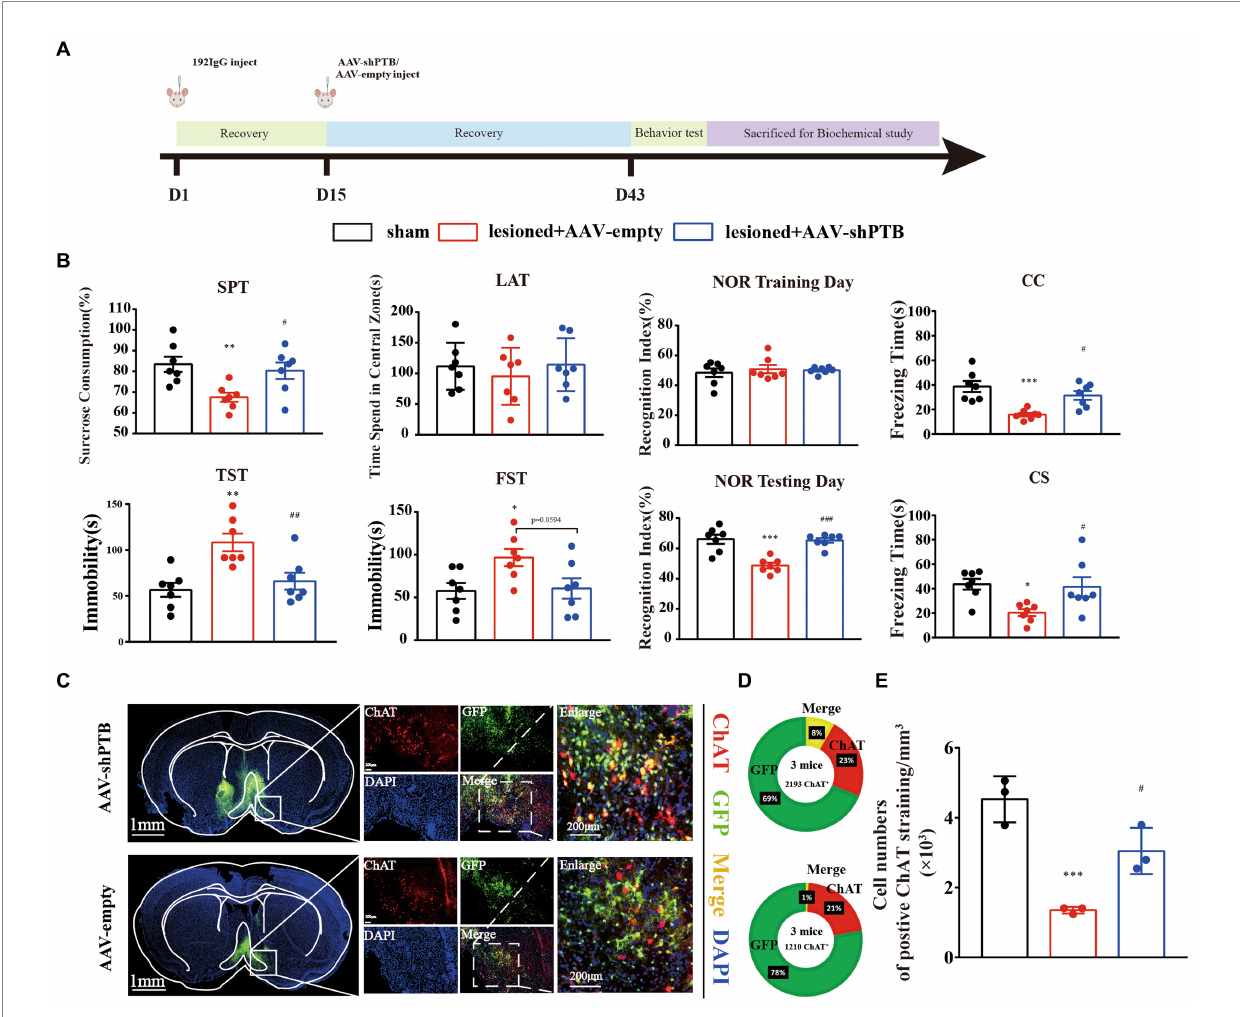
FIGURE 2 AAV-shRNA with GFAP promoters could replenish cholinergic neurons. (A) Experimental schedules. (B) The sucrose preference (one-way ANOVA, Tukey’s multiple comparisons test, F (2,18) = 6.235, ** p = 0.0099, # p = 0.0389, n = 7); immobility time in the TST (one-way ANOVA, Tukey’s multiple comparisons test, F (2,18) = 9.712, ** p = 0.0017, ## p = 0.0089, n = 7) and FST (one-way ANOVA, Tukey’s multiple comparisons test, F (2,18) = 4.407, * p = 0.0398, p = 0.0594 compared the AAV-empty group, n = 7); time spent in the central area in LAT (one-way ANOVA, Tukey’s multiple comparisons test, F (2,18) = 0.4025, p = 0.7607, compared to the sham group, p = 0.6898 compared to the AAV-empty group, n = 7); cognitive memory regarding the time to explore novel object in NOR (one-way ANOVA, Tukey’s multiple comparisons test, F (2,18) = 19.16, *** p < 0.001, ### p < 0.001, n = 7); and a short- term memory reversed in contextual fear conditioning (CC; one-way ANOVA, Tukey’s multiple comparisons test, F (2,18) = 11.36, *** p = 0.0005, # p = 0.0135, n = 7) and conditional fear conditioning (CS) in FCT (one-way ANOVA, Tukey’s multiple comparisons test, F (2,18) = 5.351, * p = 0.0215, # p = 0.0387, n = 7). (C) Virus injection sites and co-labeling of cholinergic neurons with virus. Scale bar represents 1 mm (left); scale bar represents 200 μ m (right). (D) The co-labeling rate of AAV-shRNA with green fluorescent protein and cholinergic neurons (top) and the co-labeling rate of AAV-empty with green fluorescent protein and cholinergic neurons (bottom). (E) The number of cholinergic neurons in AAV-PTB group was increasing significantly compared to the AAV-empty group, while the number of cholinergic neurons in AAV-empty group was increasing significantly compared to the sham group (one-way ANOVA, Tukey’s multiple comparisons test, F (2,6) = 25.73, *** p = 0.009, # p = 0.0205). * Means compared to sham group, # means compared to AAV-empty group. Data are expressed as mean ±